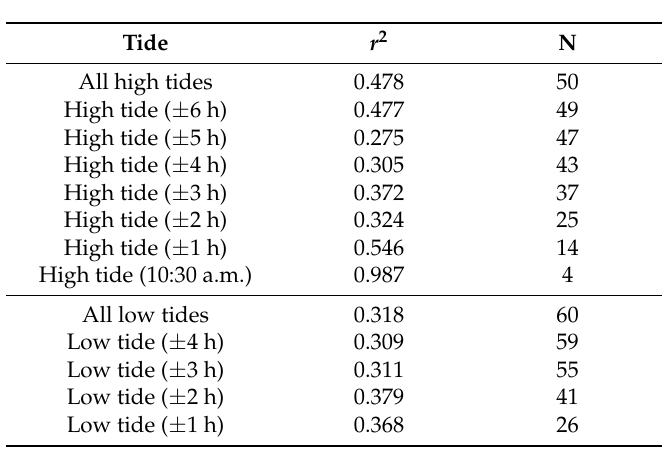
Table 2. Coefficient of determination ( r 2 value) between in situ turbidity and Band 1 reflectance with in situ measurements taken at high and low tides with images falling within a specified time gap between in situ measurement and 10:30 a.m. Terra satellite overpass.